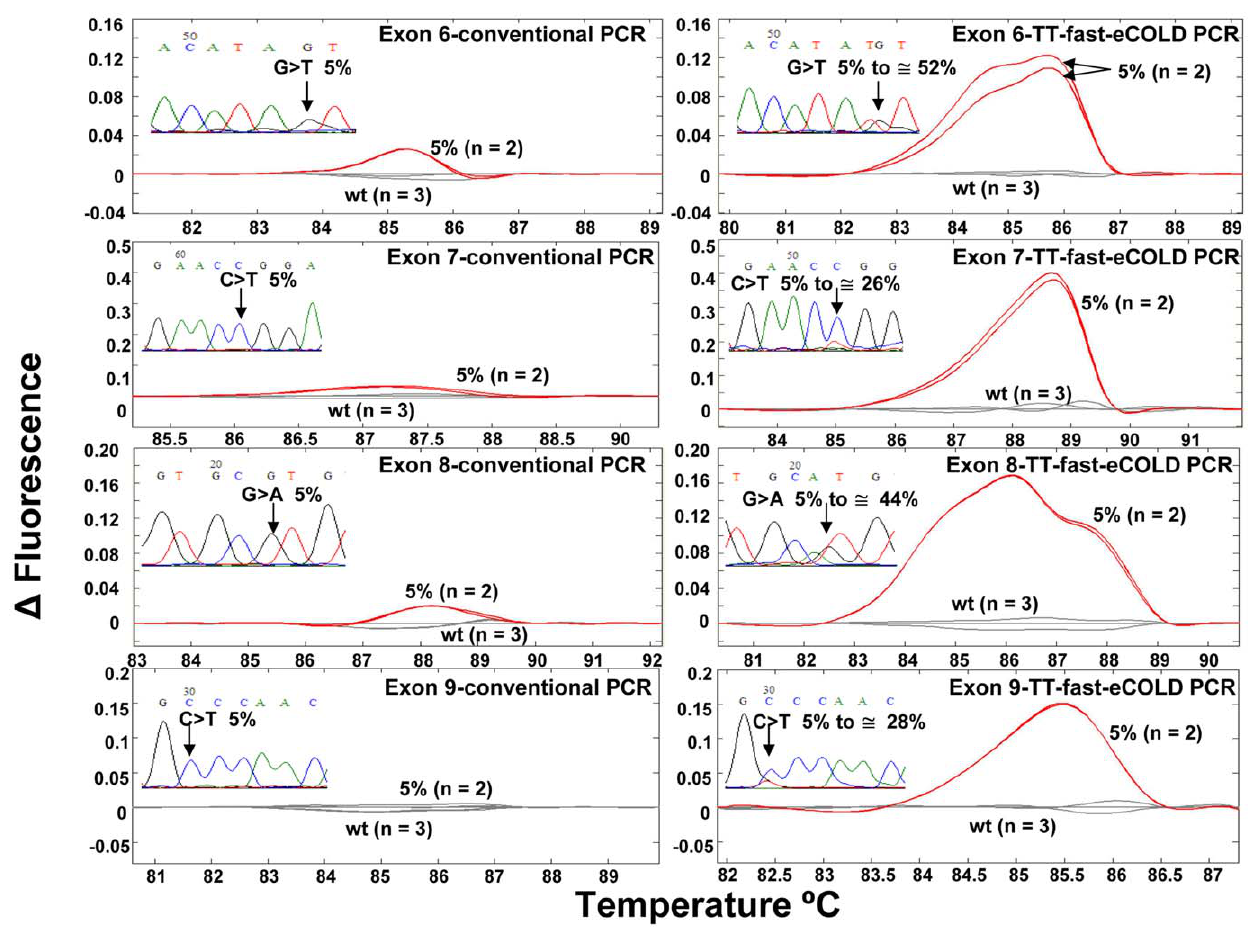
Figure 2. Temperature-tolerant COLD-PCR in emulsion, TT-fast-eCOLD-PCR: Enrichment of mutations in multiple DNA sequences in a single tube. A 5% mutation abundance was evaluated for TP53 gene exons 6–9 by conventional PCR (left panels) and TT-fast-eCOLD-PCR (right panels). Duplicate experiments are depicted in each case. The enrichment of the mutations in all four exons is estimated from the chromatograms.